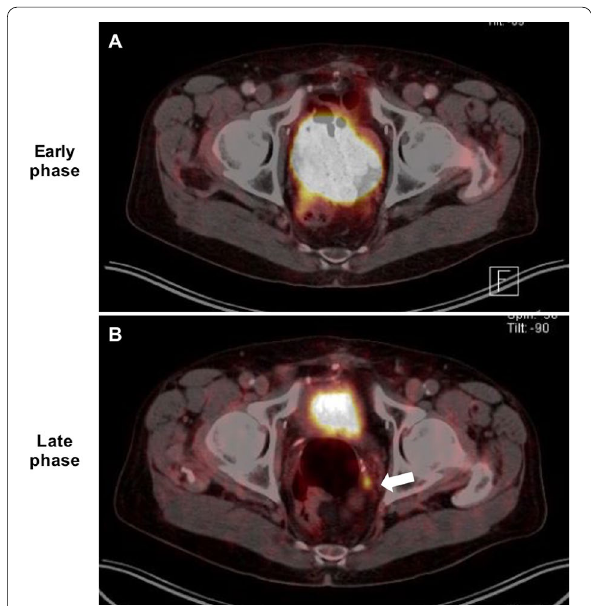
Fig. 2 Example of a 81-year old patient with biochemical recurrence (PSA 1.5 ng/ml at the time of imaging. Para-rectal local recurrence (white arrow) was detected in late phase 68 Ga-PSMA PET/CT ( B ) because of enhanced tracer uptake (SUVmax 18.3), but was PET-negative in early phase 68 Ga-PSMA PET/CT ( A ). The suspected diagnosis of local recurrence was confirmed by follow-up multiparametric pelvic MRI